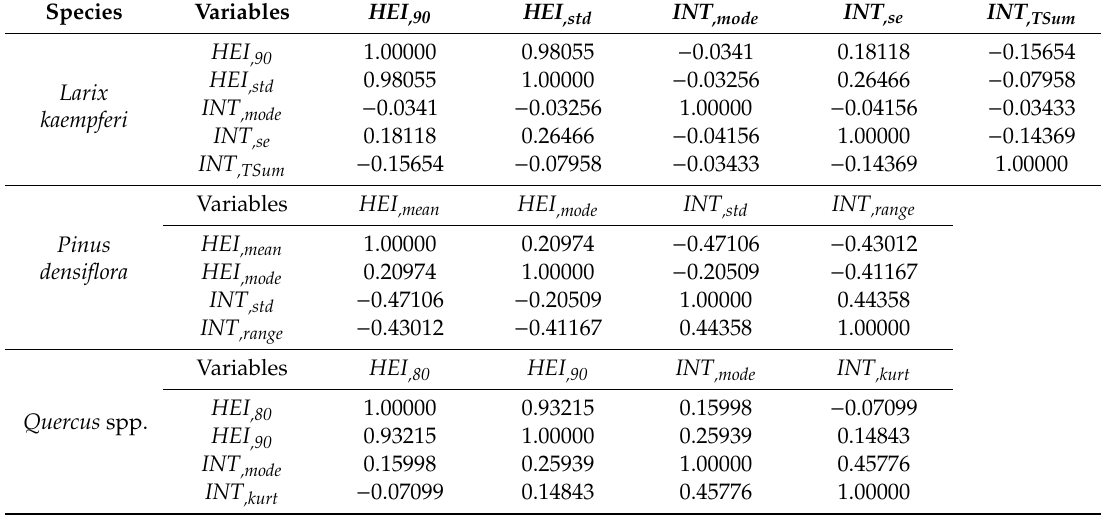
Table 5. Results of variable selection to each species by correlation coe ffi